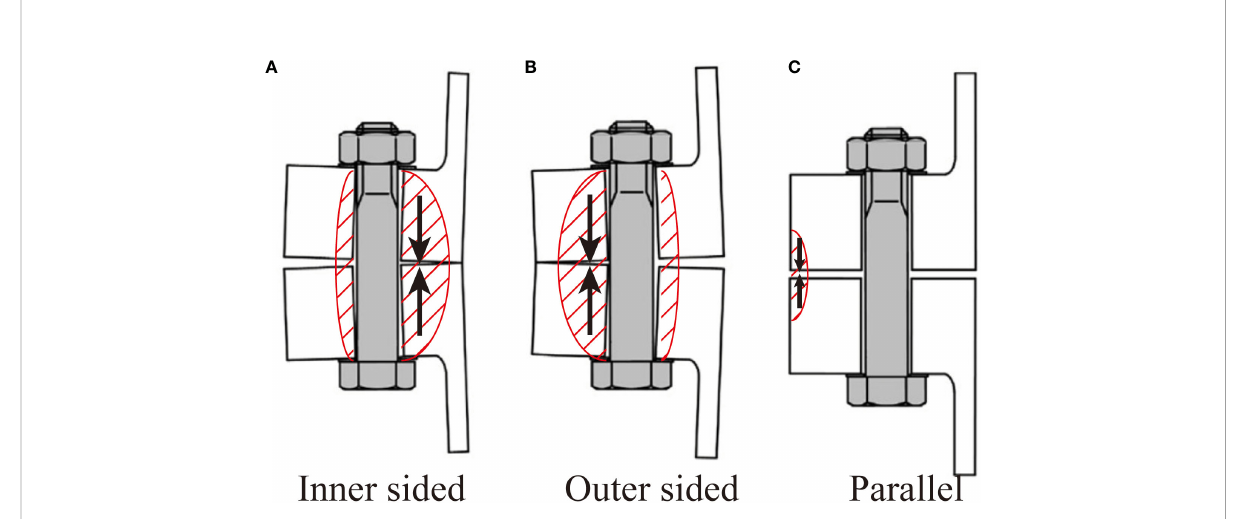
FIGURE 8 Clamp forces in imperfect bolted fl anges. (A) Inner sided; (B) Outer sided; (C)